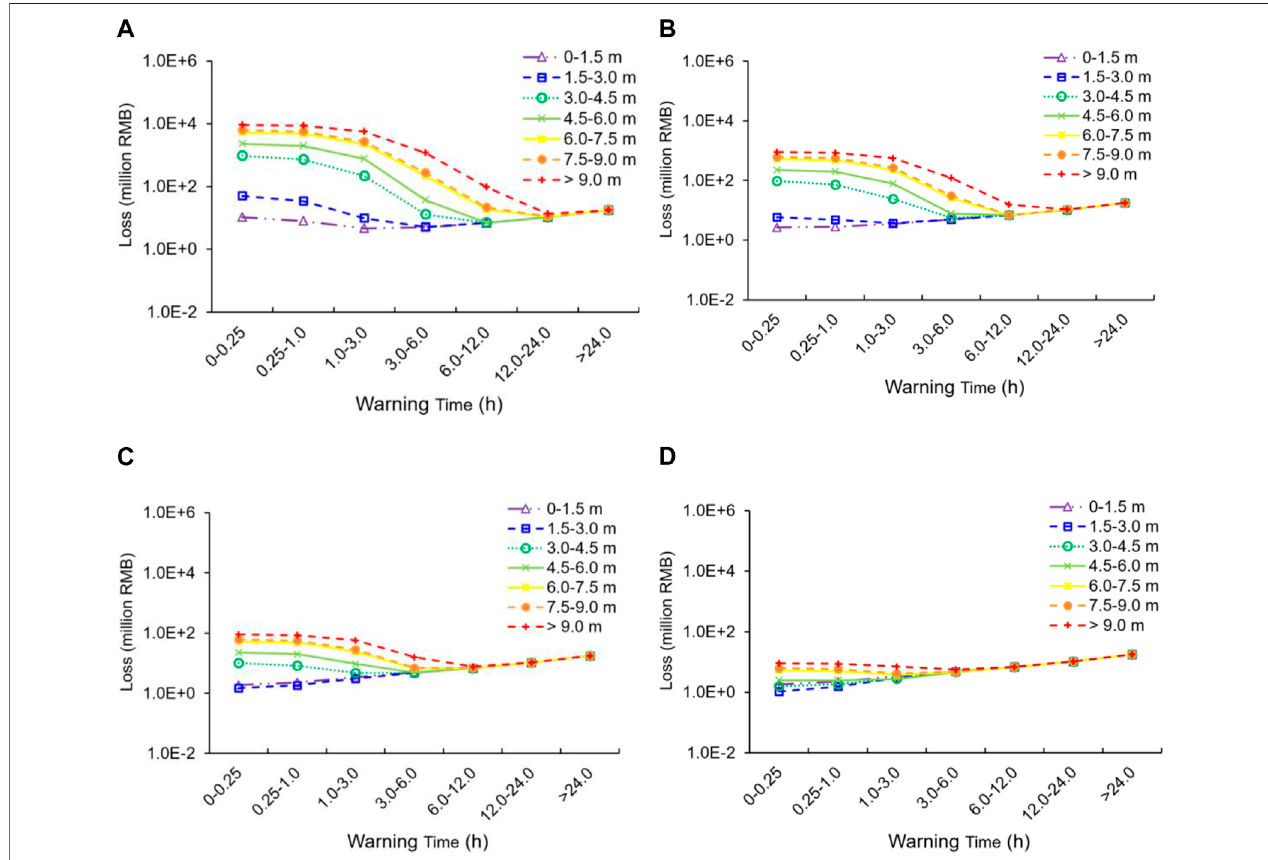
FIGURE 14 | The expected total loss in Scenario 1 in Beichuan County with different D w and W t : (A) P f (cid:2) 1; (B) P f (cid:2) 0.1; (C) P f (cid:2) 0.01; (D) P f (cid:2) 0.001.